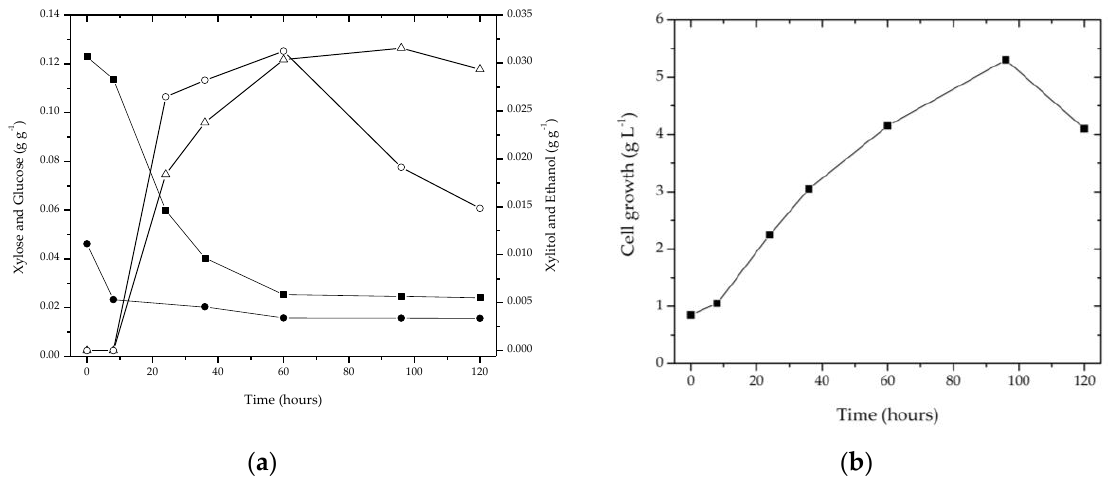
Figure 5. ( a ) Fermentation profile in the sisal fiber hydrolysate: ( ■ ) xylose, (∆) xylitol, ( ○ ) ethanol, Figure 5. ( a )Fermentation profile in the sisal fiber hydrolysate: ( (cid:4) ) xylose, ( ∆ ) xylitol, ( ( ) glucose; ( b ) Cell (●) glucose; ( b ) Cell growth.